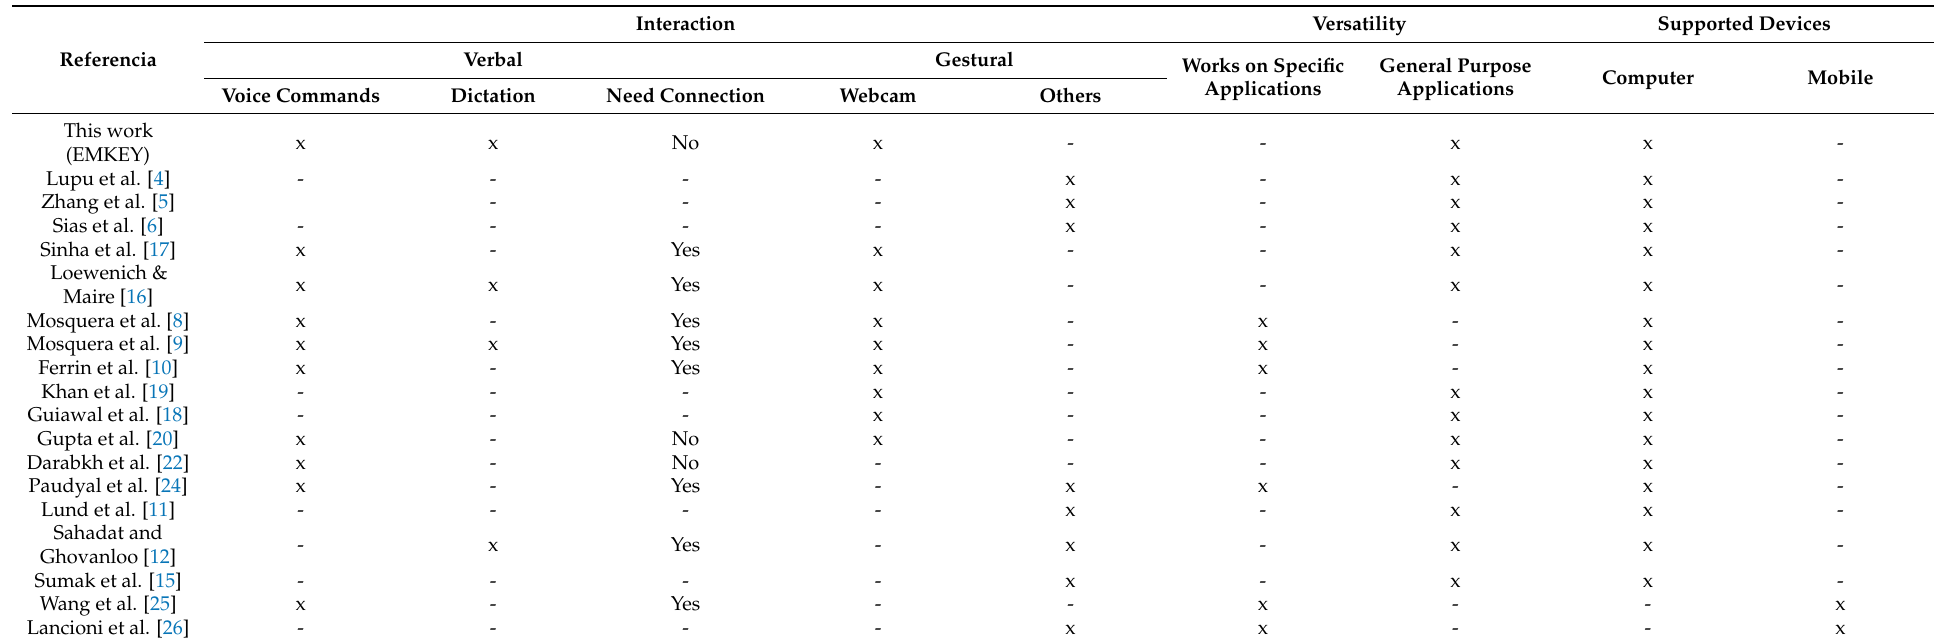
Table 7. Comparison table of EMKEY with other